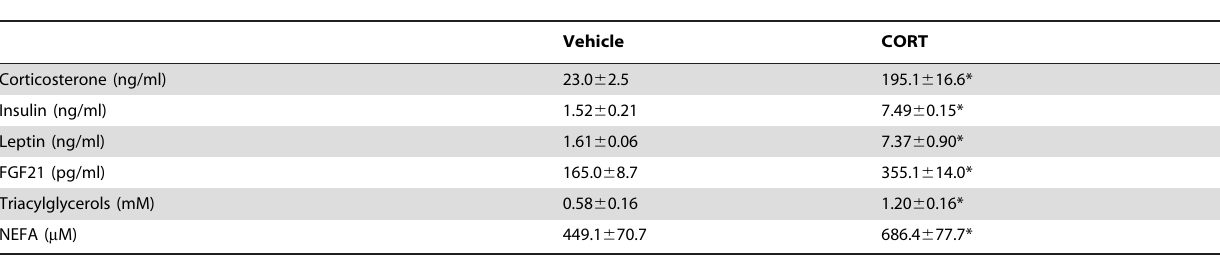
Table 2. Effect of CORT on plasma hormone levels and lipid profile of